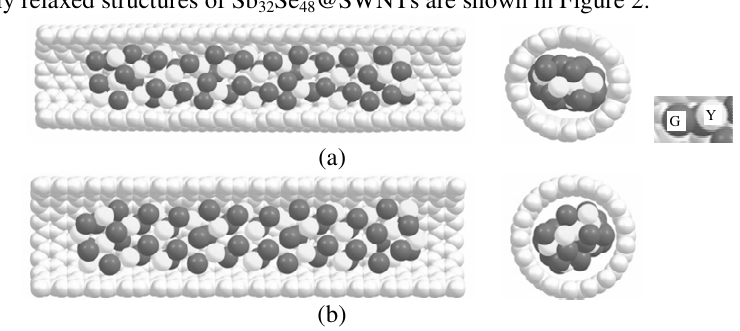
Figure 2. (a). Optimised structures of (a). Sb Geometrical parameters for the central motifs of the Sb optimizations of Sb Se @SWNT [SWNT= (9,9), (17,0)] and isolated Sb 32 48 shown in Table 3 and Table 4. Table 3. Structural parameters (bond lengths) calculated for Sb [SWNT = (9,9) and (17,0)]: d is the diameter of the (empty) SWNT; Structural data for an t isolated and model Sb Se @SWNT structure are also provided. 32 48